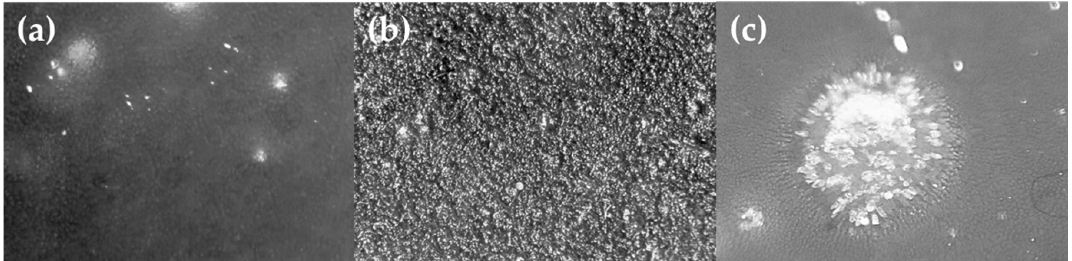
Means ± standard deviation, n = 9. * Different letters in the same column indicate significant differences ( p ≤ 0.05).